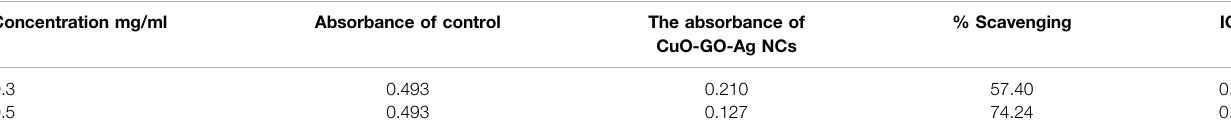
TABLE 6 | CuO-GO-Ag NCs IC50 value and percent scavenging.